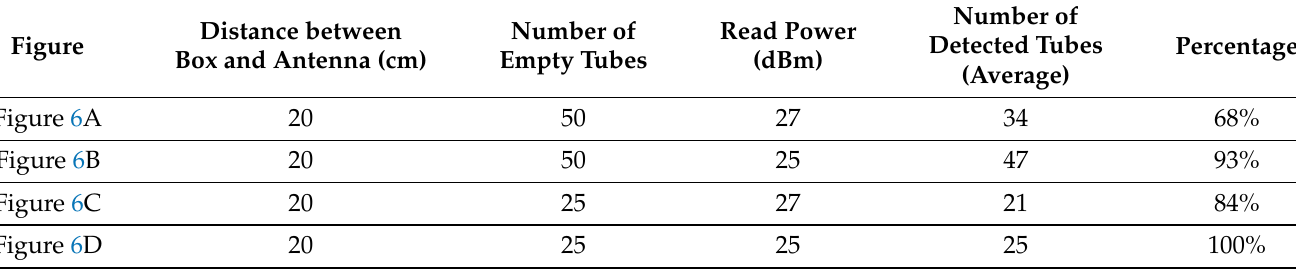
Table 2. The results of the experiments determining the number of tubes inside the transport box. Distance between Figure Box and Antenna